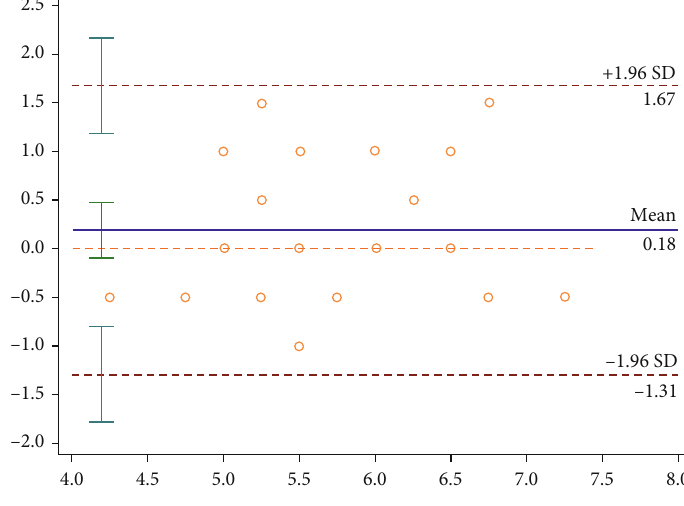
Figure 3: Mean of pairs 5 and